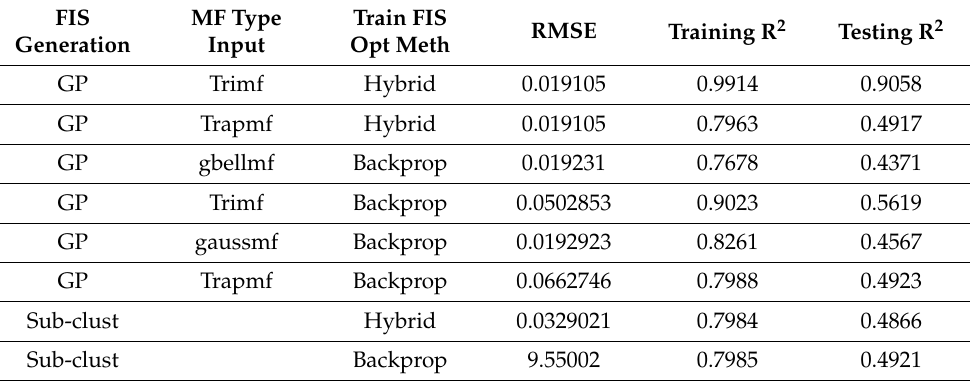
Figure 8. ANFIS model structure. Table 3. ANFIS training results.